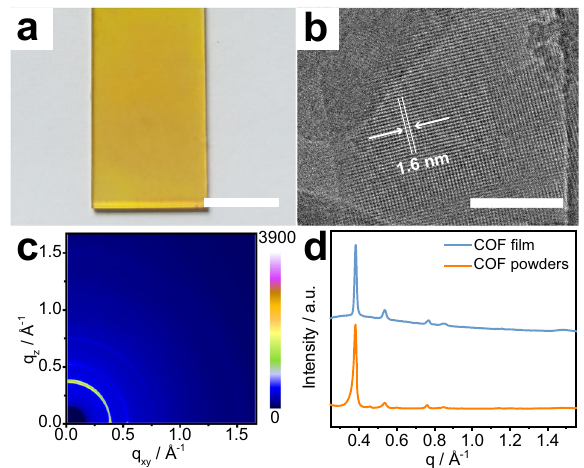
Fig. 2 | Characterization of COF TPDA-TFPy fi lm. a Photograph of COF TPDA-TFPy fi lm. (Scale bar: 1cm) b TEM images of COF TPDA-TFPy fi lm. (Scale bar: 50nm) c GIWAXS data of the COF TPDA-TFPy fi lm on glass substrates. d Projections of GIWAXS data of COF TPDA-TFPy fi lms near q z =0 (Blue) and PXRD data of COF TPDA-TFPy powder